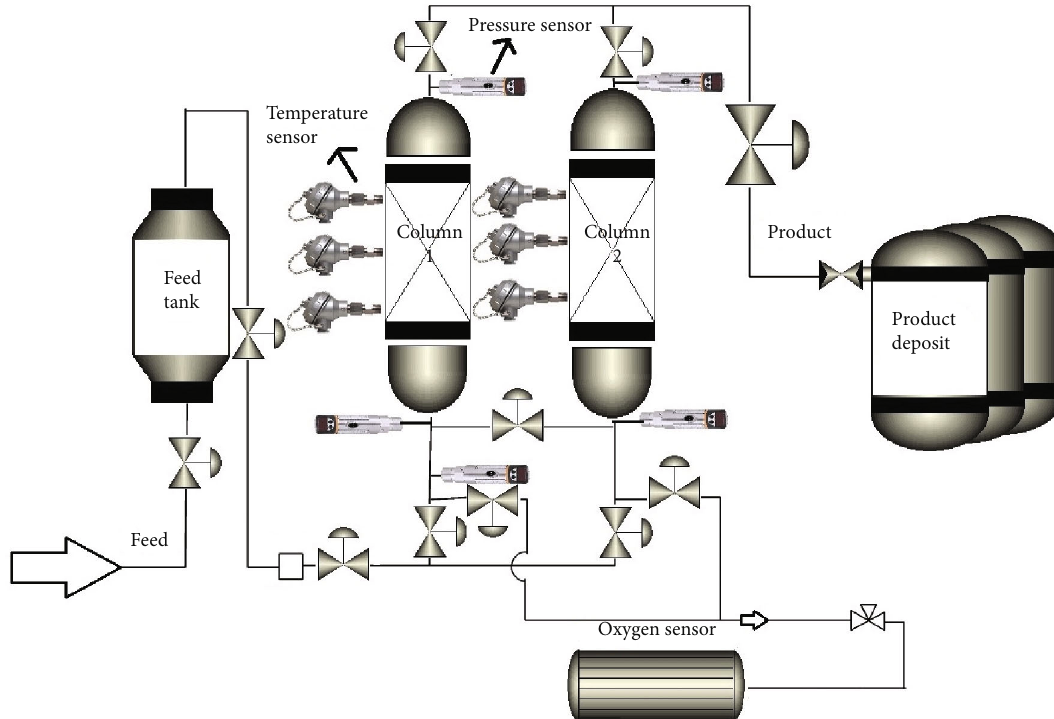
Figure 9: Schematic diagram of the PSA process using 2-beds, 6-steps. Table 16: Distributed parameter models of the PSA processes for medical oxygen production. Reference Equations governing the PSA process (nonlinear